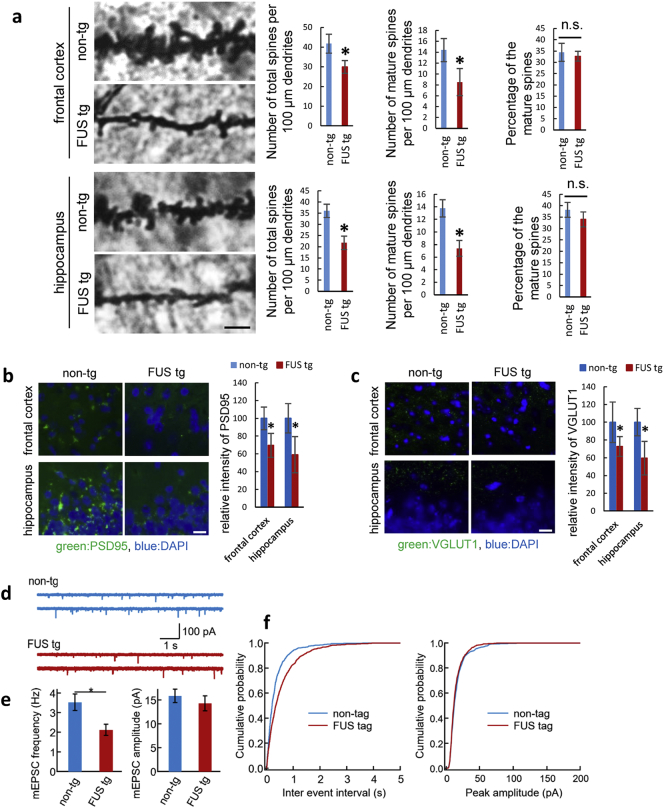
FUS transgenic mice showed synaptic impairment.(a) Representative figure of Golgi staining in the frontal cortex and hippocampus of FUS transgenic (n = 3) and non-tg (n = 3) mice. Dendritic spine number was quantified along a 100-μm segment from the origin of the primary apical dendritic branches of the pyramidal neurons. Asterisks (*) indicate significant differences vs. non-tg mice (P < 0.05 by Student's t-test). (b, c) Immunohistochemistry for quantification of postsynaptic density 95 (PSD95) protein (b) and vesicular glutamate transporter 1 (VGLUT1) (c) in the frontal cortex and hippocampus of FUS transgenic and non-tg mice (n = 3 per genotype, P < 0.05 by Student's t-test). Scale bar, 20 μm. (d) Whole-cell patch-clamp recordings of mEPSCs in pyramidal neurons of the frontal cortex. The amplitude and frequency of these miniature events were compared between FUS transgenic and non tg mice (P = 0.58 and 0.015 by Wilcoxon rank test for amplitude and frequency, respectively). (e, f) Cumulative distributions of mEPSC frequency and amplitude in the frontal cortex of FUS transgenic and non tg mice (P < 0.01 and 0.16 by Kolmogorov–Smirnov test for frequency and amplitude, respectively).